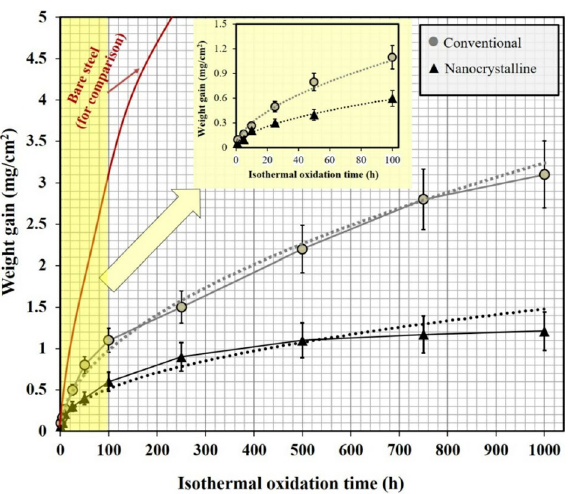
Figure 12. Average weight gain against isothermal oxidation time under long-term oxidation for the conventional and nanocrystalline MCrAlY coatings (15 h milled under 300 rpm) at 1100 °C.